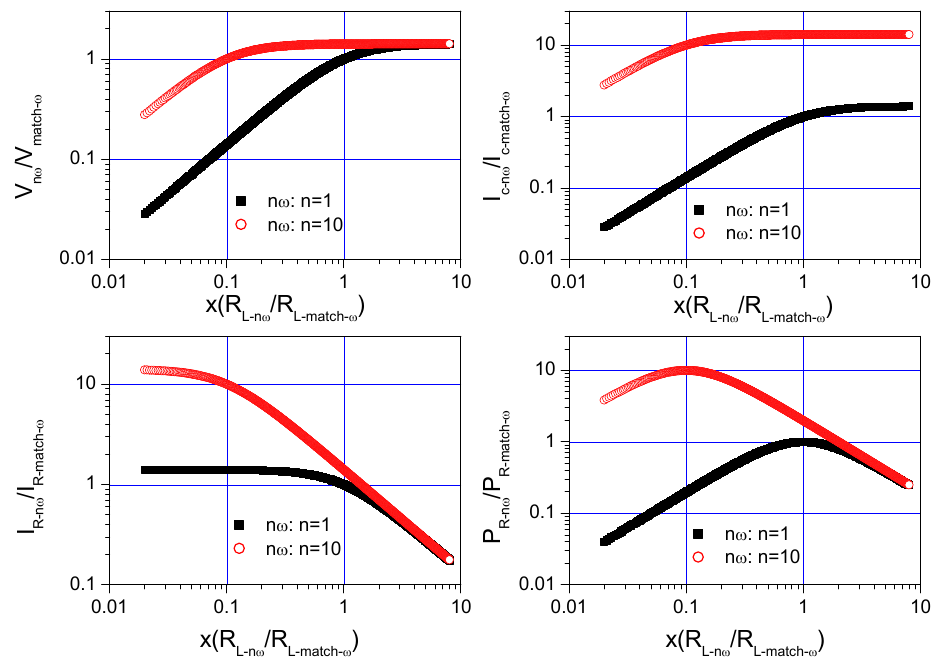
Figure 4. Numerical solutions of the model.